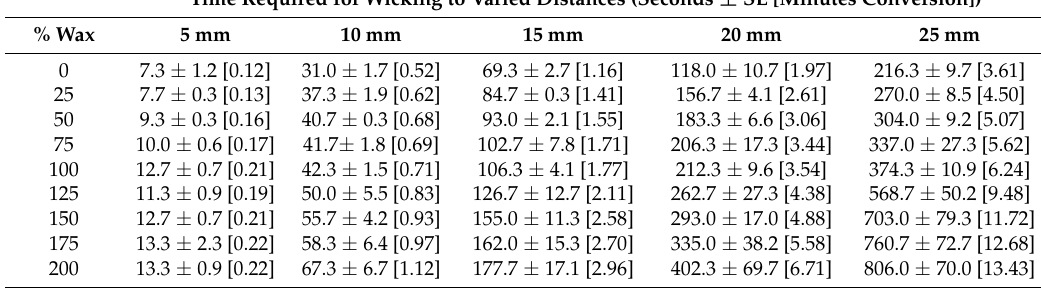
Figure A1. Graph of wicking distance (10 µ L dye) as a function of % wax channel coverage. There was a significant difference in wicking distance across the different channels (F = 19.75, df = 8, p < 0.0001). However, there was no significant difference between channels ranging from 75–200% wax coverage ( p > 0.25). Letters above bars represent significant differences. Table A1. Raw data for graph in Figure 1C ( n = 3). Wicking time increases with both % wax coverage and channel length. Standard error also tends to increase for longer time points. Channels were 3 mm wide. SE = standard error of the mean.